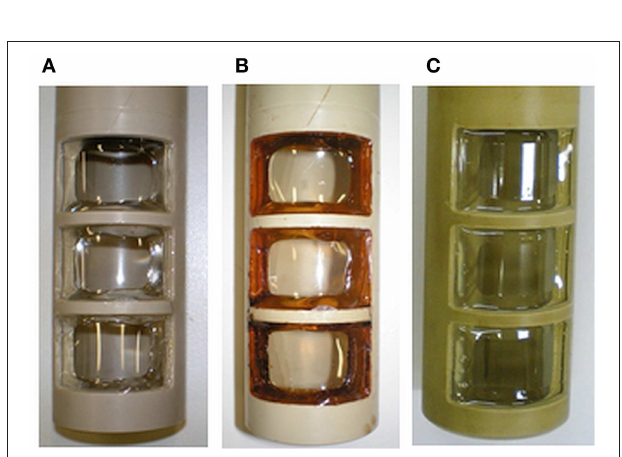
FIGURE 8 | Glued membrane before (A) and after sterilization with dry heat (B) and γ -radiation (C) .